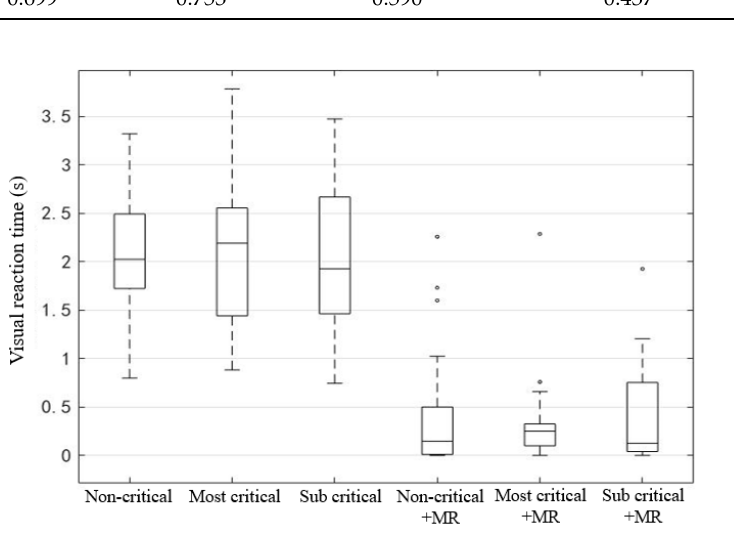
Figure 7. Visual reaction time of six different scenarios.